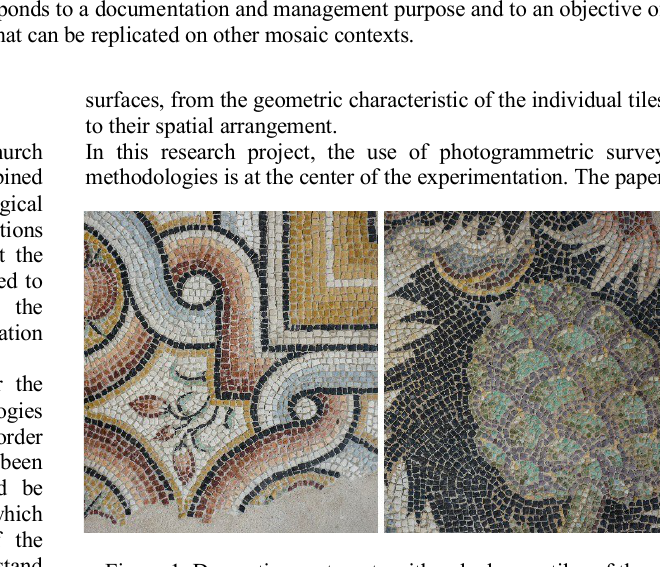
Figure 1. Decorative vestments with polychrome tiles of the mosaic